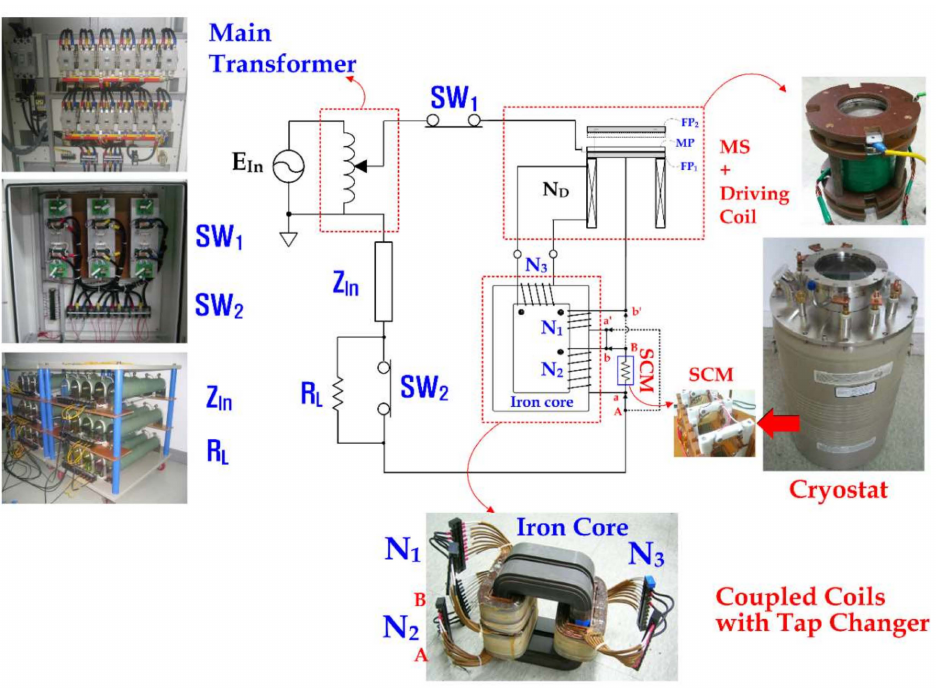
Figure 4. Schematic experimental test circuit with the proposed SFCLB using flux coupling with a tap